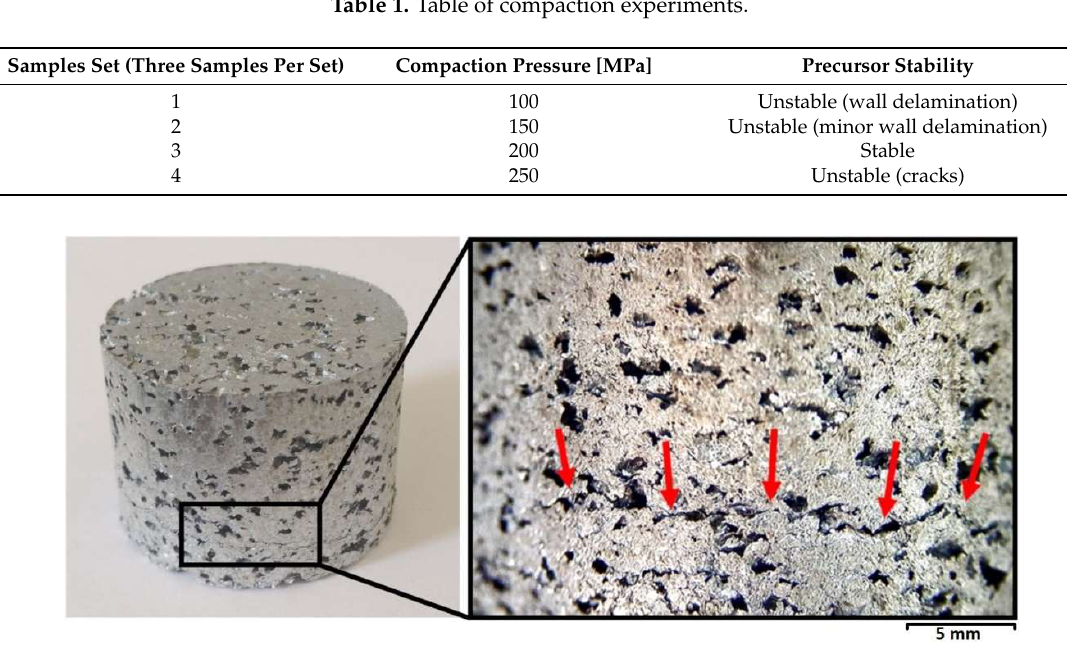
Figure 3. Sample set 4. Red arrows indicate a major crack caused by compaction pressures of 250